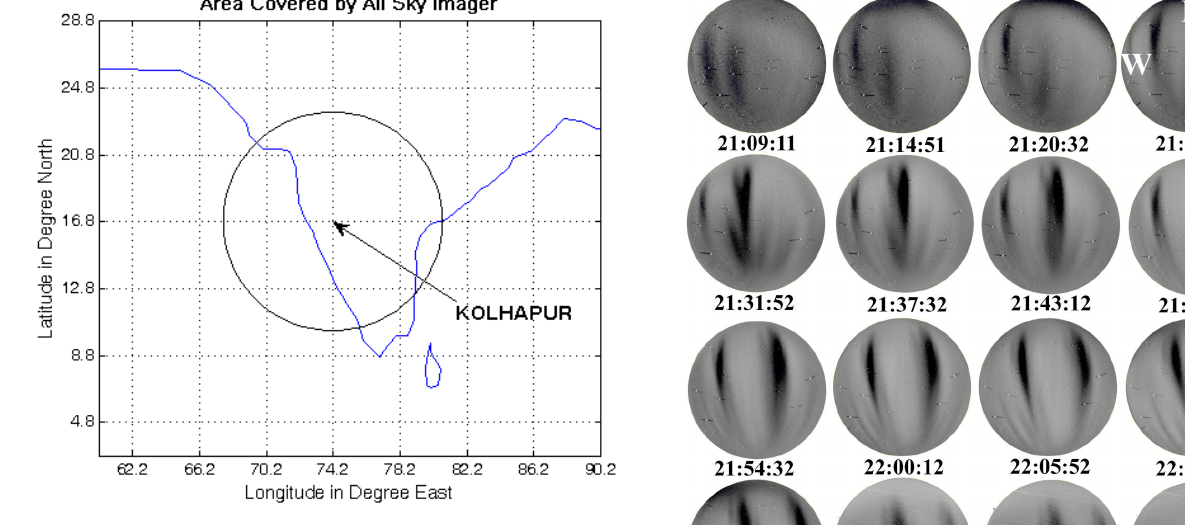
Fig. 1. The location of the Kolhapur and area covered by ASI (FOV 140º) at an altitude 250 km where 630.0 nm emissions are generated.